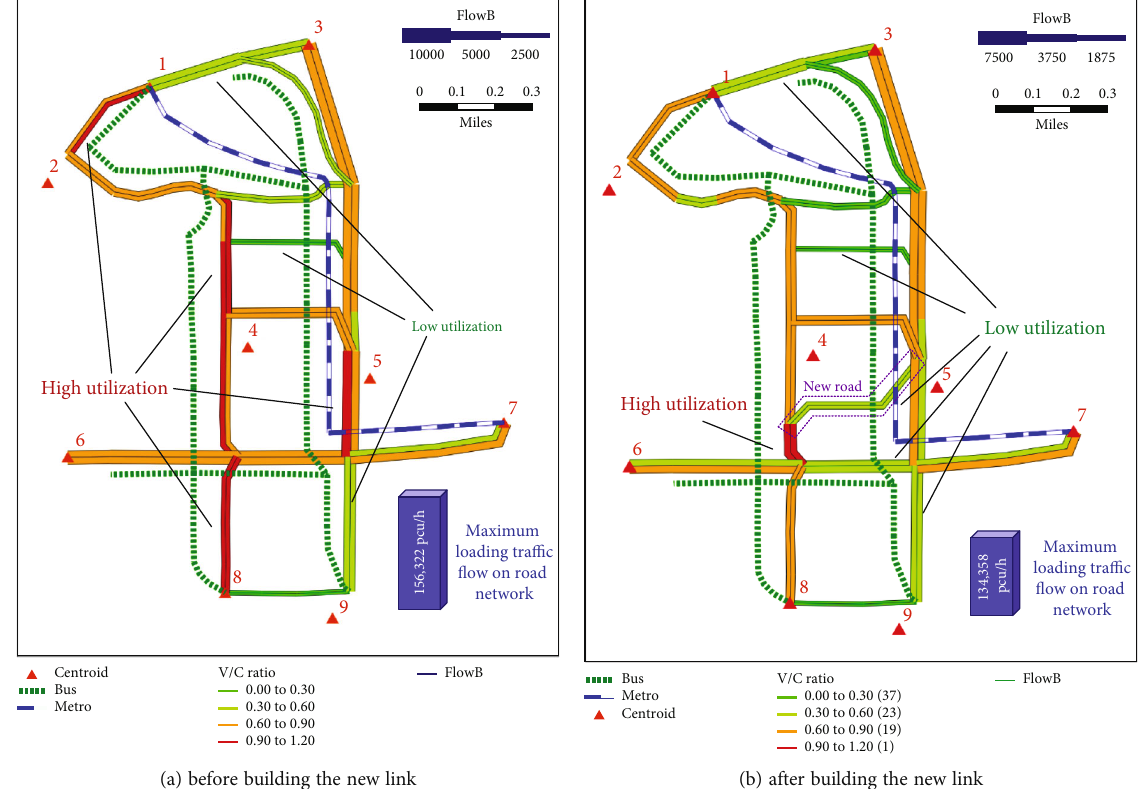
Figure 14: Maximum fl ow pattern on road network.